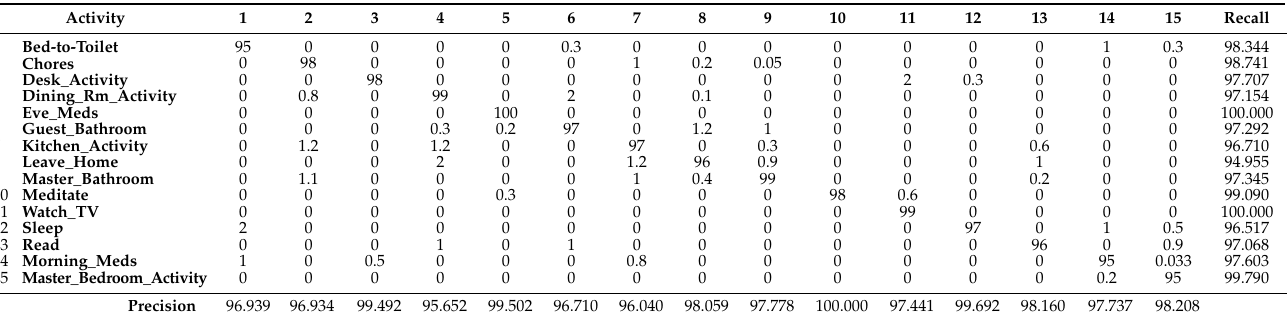
Table 3. Confusion matrix for Milan